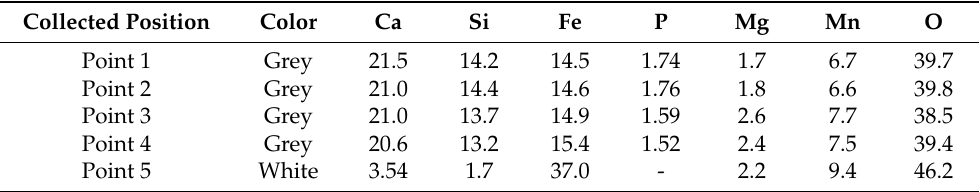
Figure 5. Scanning electron microscope (SEM) micrograph (backscattered electron) of the dephos- phorization slag in Heat 1. Table 4. Energy dispersive spectrometry (EDS) analysis results (wt.%) of dephosphorization slag in Heat 1 corresponding to Figure